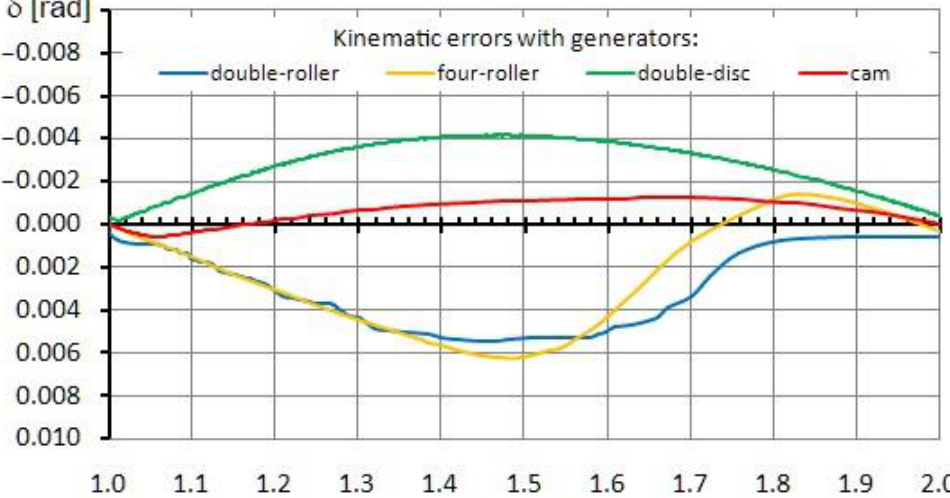
Figure 13. Kinematic errors of the circular spline are the result of the generator excitation of different types of generators.